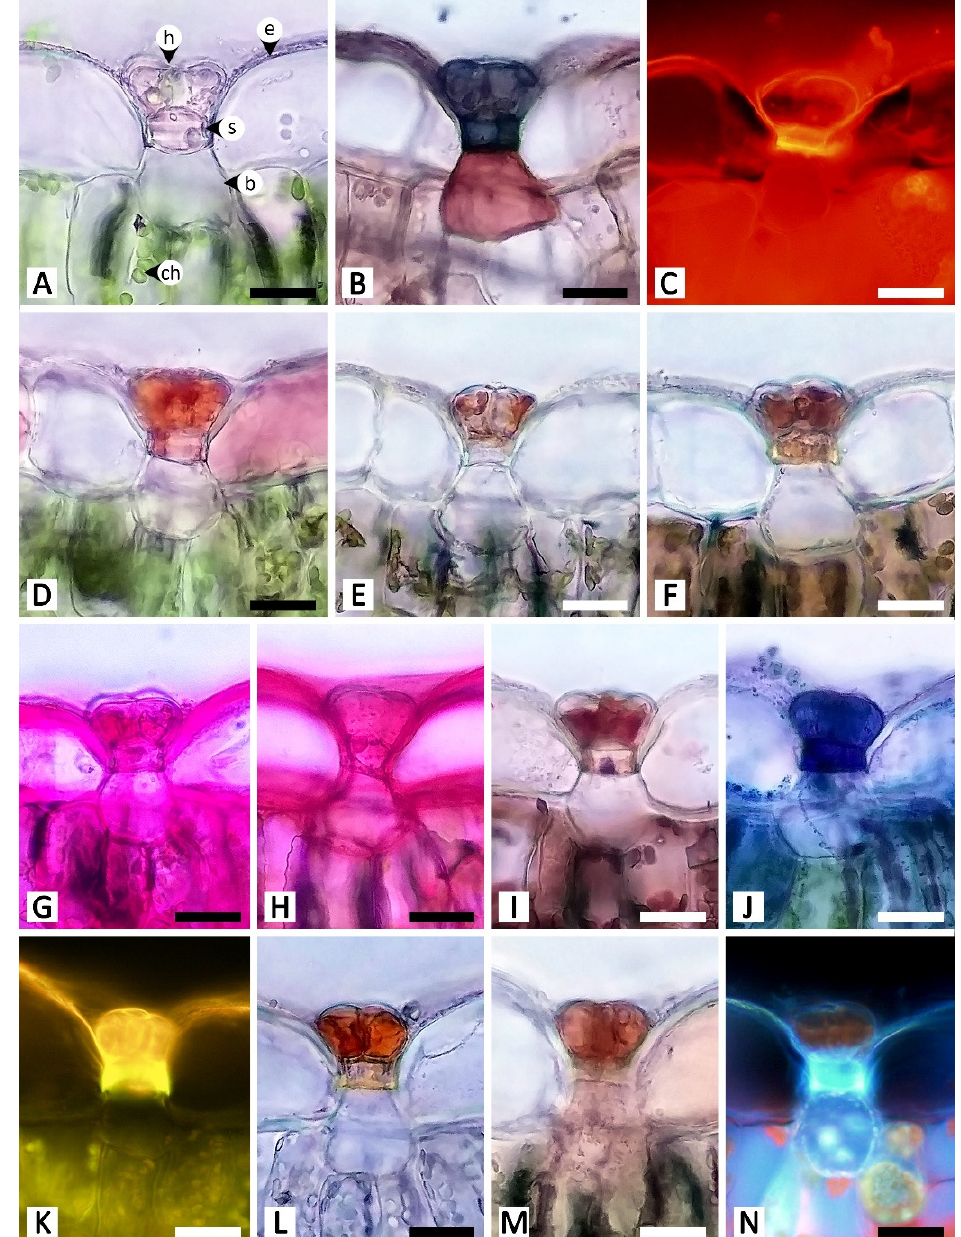
Figure 8. Histochemical results obtained from foliar glands of Rivea ornata . ( A ) Unstained foliar gland. ( B ) Sudan black B test for total lipids. ( C ) Neutral red fluorochrome test for total lipids. ( D ) Ferric chloride test for phenolic compounds. ( E ) Potassium dichromate test for phenolic compounds. ( F ) Lugol’s iodine test for starch. ( G ) Periodic acid–Schiff’s reagent (PAS) test for neutral polysaccharides. ( H ) Ruthenium red test for acidic polysaccharides. ( I ) Mercuric bromophenol blue test for proteins. ( J ) Nadi reagent test for terpenoids. ( K ) Naturstoff reagent A under fluorescent microscopy detecting flavonoids. ( L ) Dragendorff reagent test for alkaloids. ( M ) Wagner’s reagent test for alkaloids. ( N ) UV autofluorescence of foliar gland. Note: ( B – E , G , H , J – M ) show positive reactions, while ( F , I ) show negative reactions. Abbreviations: ch, chloroplast; b, base; e, epidermal cell; h, head; s, stalk. Scale bars 20 μ m.